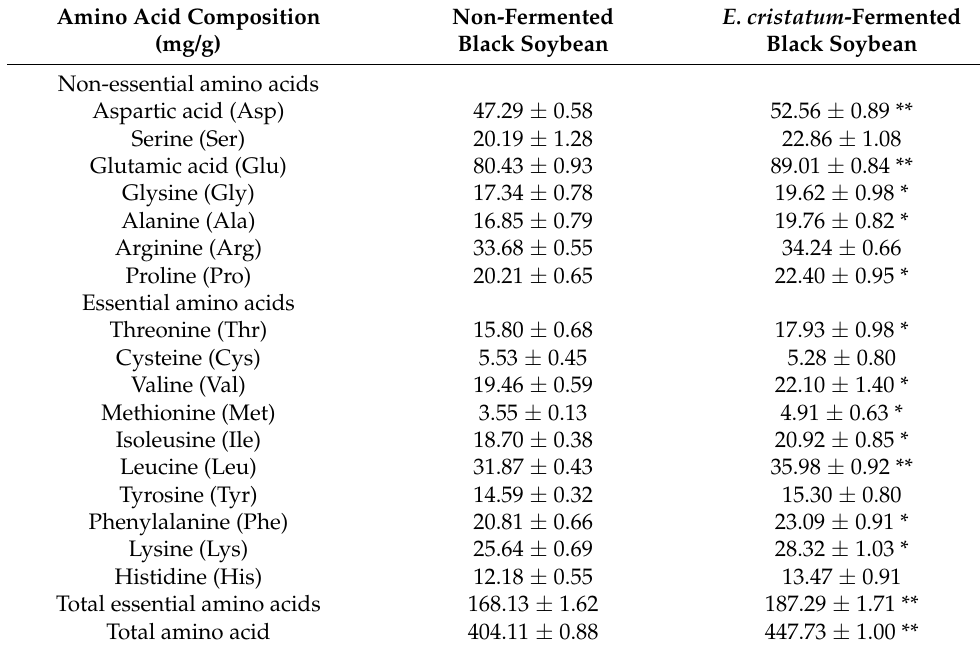
Table 2. Amino acid compositions of E. cristatum -fermented and non-fermented black soybeans. E. cristatum -Fermented Amino Acid Composition Non-Fermented (mg/g) Black Soybean Black Soybean Non-essential amino acids Aspartic acid (Asp) 47.29 ±